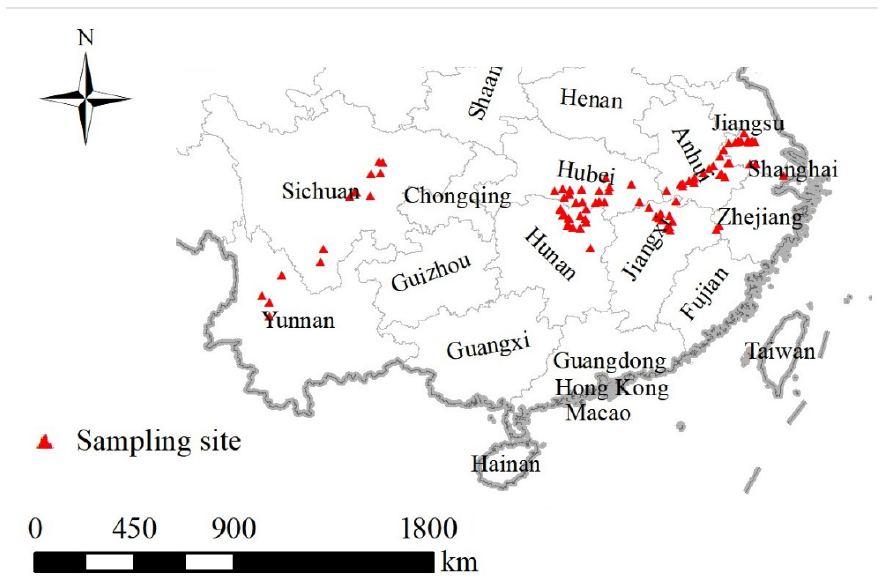
Figure 1. The geographical locations of historical host snail records. A total of 92 villages were selected as the sample sites due to their reported cases of schistosomiasis during the years 2005 to 2014. The snail records in each sample site were obtained from the National Schistosomiasis Surveillance Program.